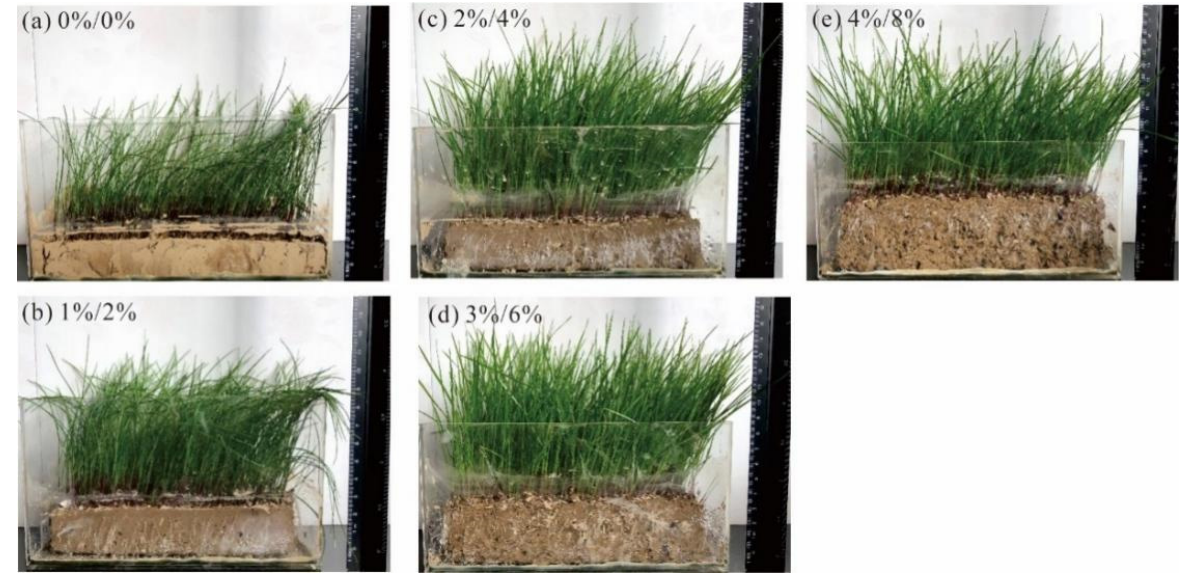
Figure 12. Vegetation growth state in 716 h: ( a ) PVA content: 0%, attapulgite: 0%; ( b ) PVA content: 1%, attapulgite: 2%; ( c ) PVA content: 2%, attapulgite: 2%; ( d ) PVA content: 3%, attapulgite: 6%; ( e ) PVA content: 4%, attapulgite: 8%.